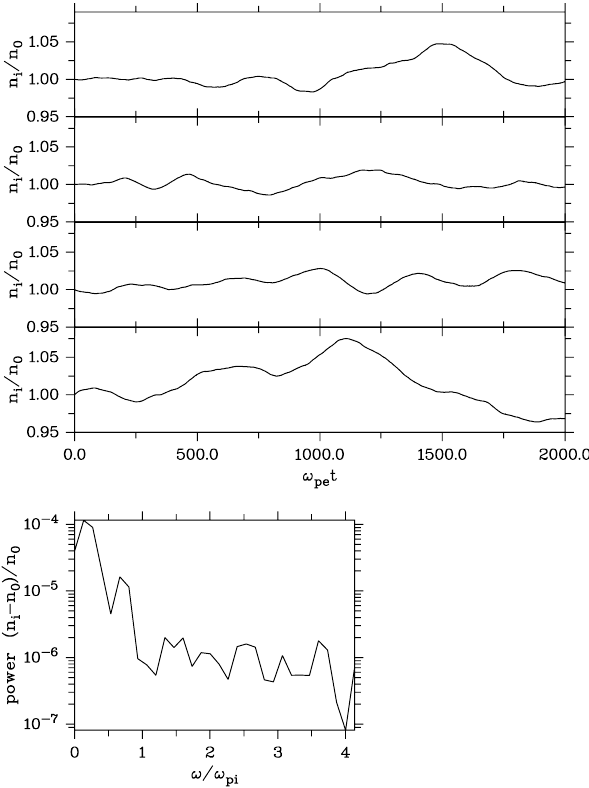
Figure 6. Time profiles of proton density at four positions x/λ D = 600 , 1200 , 1800 , 2400 within the box (top) and power spectrum averaged over the four profiles; frequency normalized by the ion plasma frequency ω pi (bottom). Parameters as in Fig. 1.